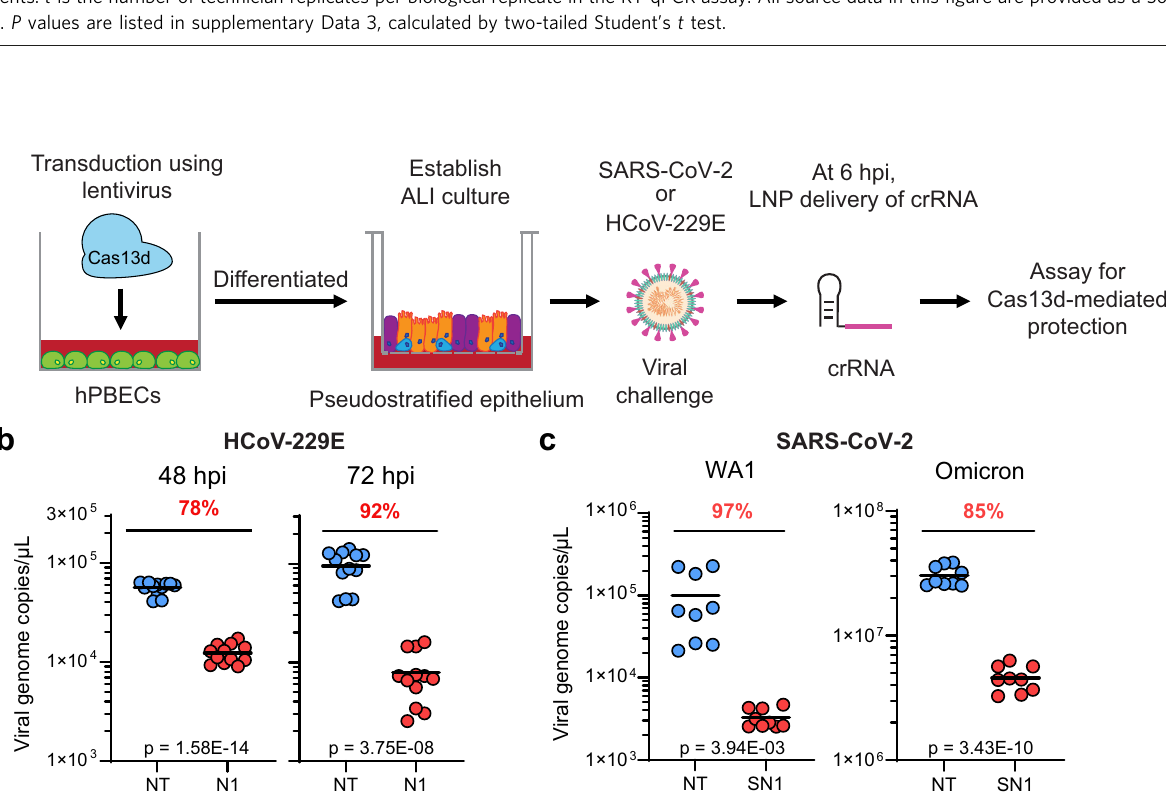
Fig. 5 Cas13d antivirals can treat established viral infection in cell lines. a Schematic of the antiviral treatment of SARS-CoV-2 infection in Vero E6/NES- Cas13d cells. b Treatment test of Cas13d targeting SARS-CoV-2 in Vero E6/NES-Cas13d cells. At 6 hpi, the cells were transfected with crRNA (Synthego), NT or SN1, using LNP. At 48 hpi, the virus titer in the media was quanti fi ed using both RT-qPCR and plaque assays; n = 4, t = 3. d The antiviral drug EIDD- 1931 was added to the media in combination with the Cas13d; n = 3, t = 3. c , e – g Treatment test of Cas13d targeting 229E in MRC-5 cells. At 0, 1, 3, and 6 hpi, the cells were transfected with NES-Cas13d mRNA (Trilink) and crRNA (Synthego) using lipofectamine MessagerMAX (Invitrogen). The indicated small-molecule antiviral drug was added to the media 20 min after the transfection. At 48 hpi, virus titer in the supernatant was measured by RT-qPCR. The viral genomic copies of Cas13d treatment with no drug ( c ) or combined with a small-molecule drug ( e ) are plotted separately; n = 3, t = 3. At 72 hpi, the cells were stained with crystal violet ( f ) and the percent vial cells were quanti fi ed using Fiji ImageJ ( g ); n = 3. n is the number of independent biological experiments. t is the number of technician replicates per biological replicate in the RT-qPCR assay. All source data in this fi gure are provided as a Source